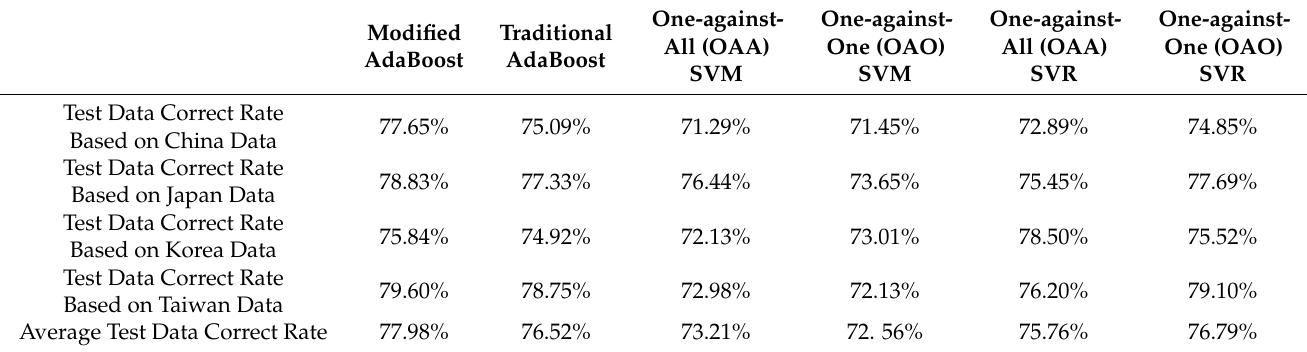
Table 5. Predictive ability of the modified AdaBoost comparison in different kinds of machine learning methods in multi-class